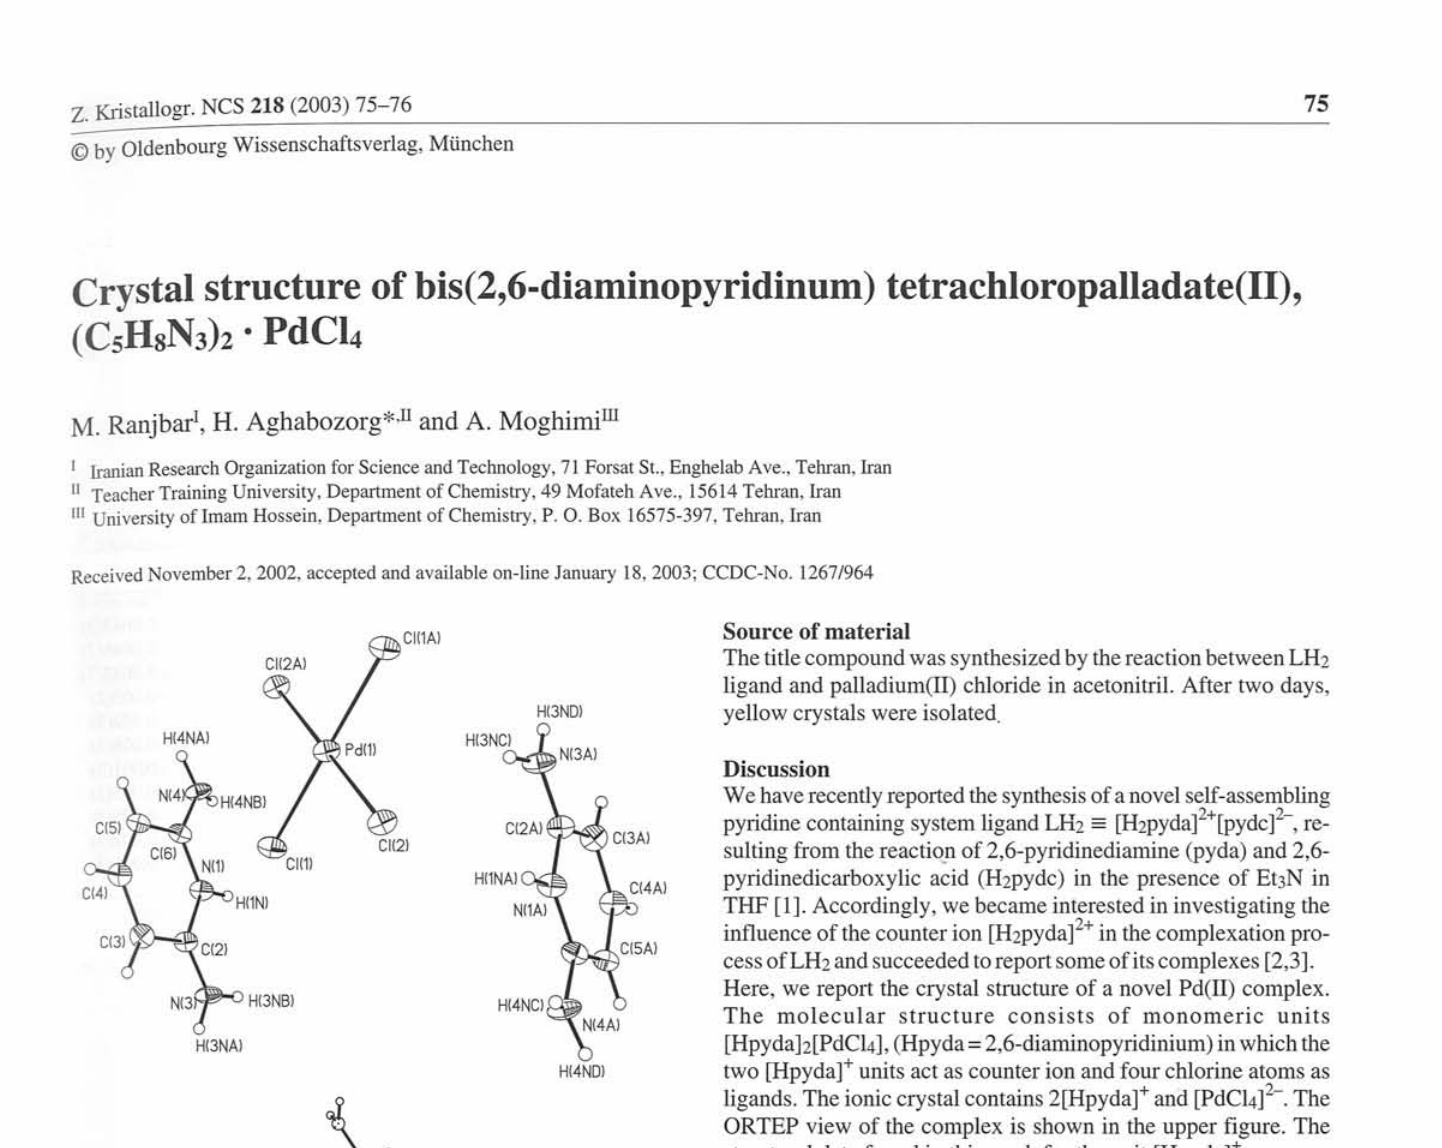
Table 1. Data collection and